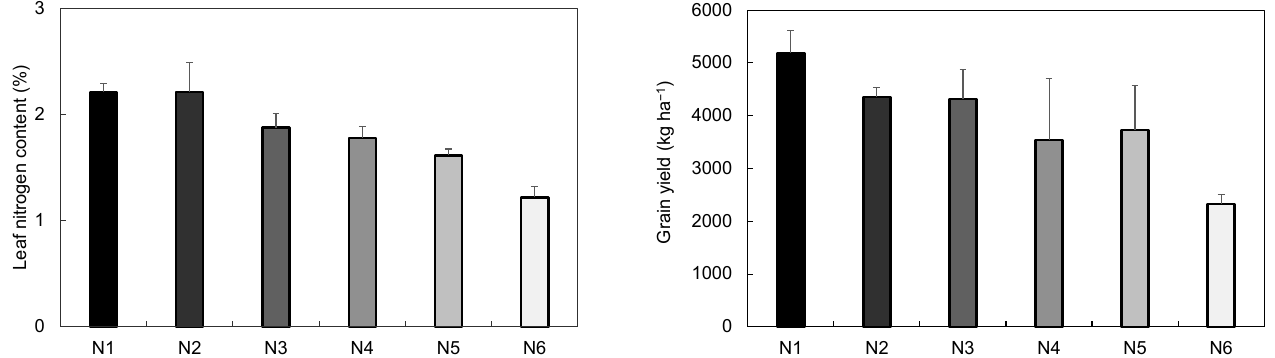
Figure 2. Leaf nitrogen content and seed weight of wheat plants with different N top–dressing rates.